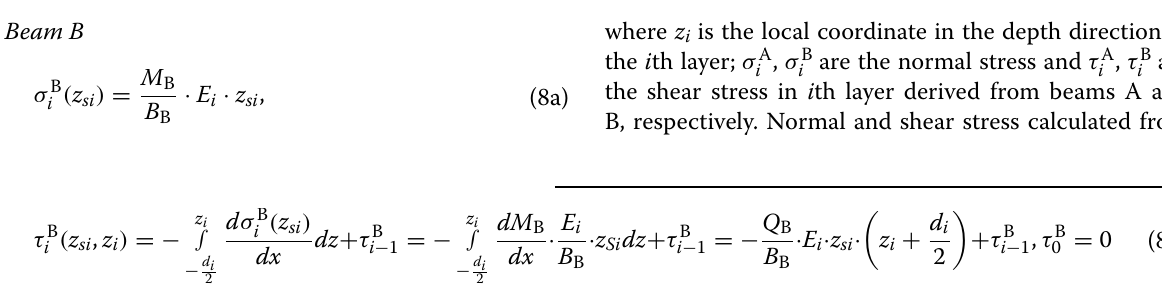
τ A τ B i , i are